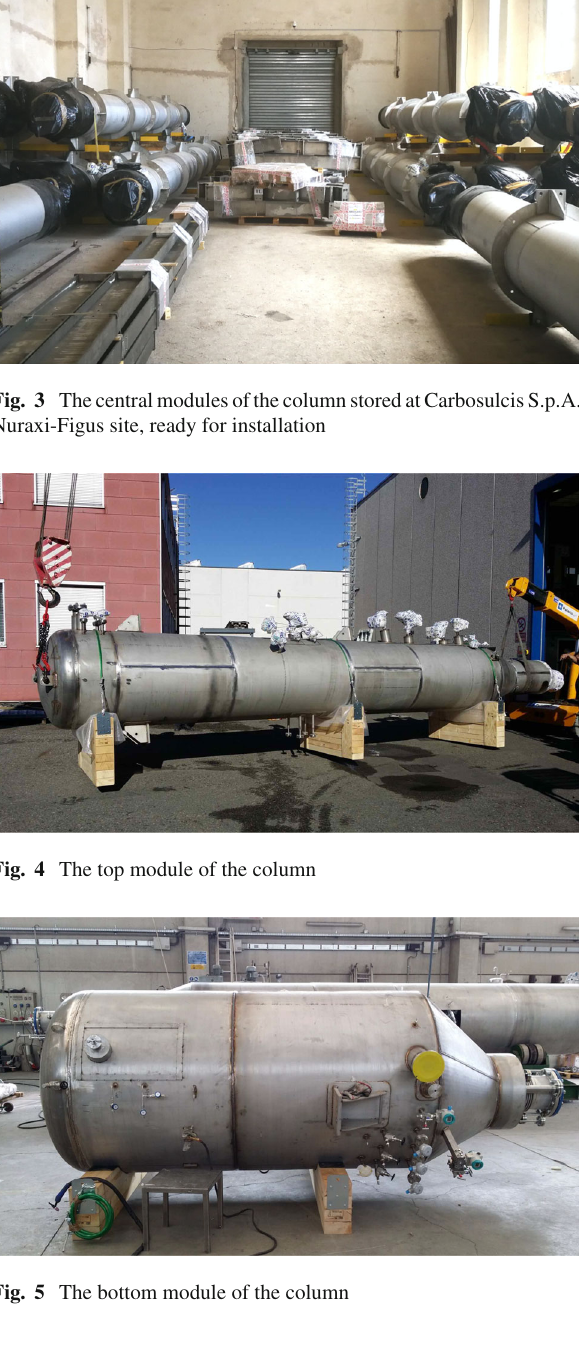
presence of bellows, the support of each module is indepen- dent of the others. The load is distributed laterally to the shaft walls. Every module is supplied with anchor points, whose sizing takes into consideration both the static weight and the stresses due to the cold box operating pressure. The anchor points are bolted to a structure, discussed in Sect. 4.3, which is fixed to the lateral wall of the